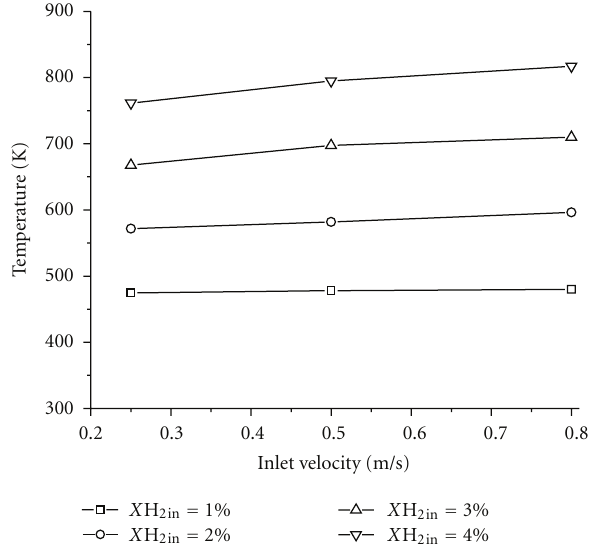
Figure 12: Outlet hydrogen concentration as a function of inlet velocity and inlet hydrogen concentration for REKO facility with inlet temperature 383